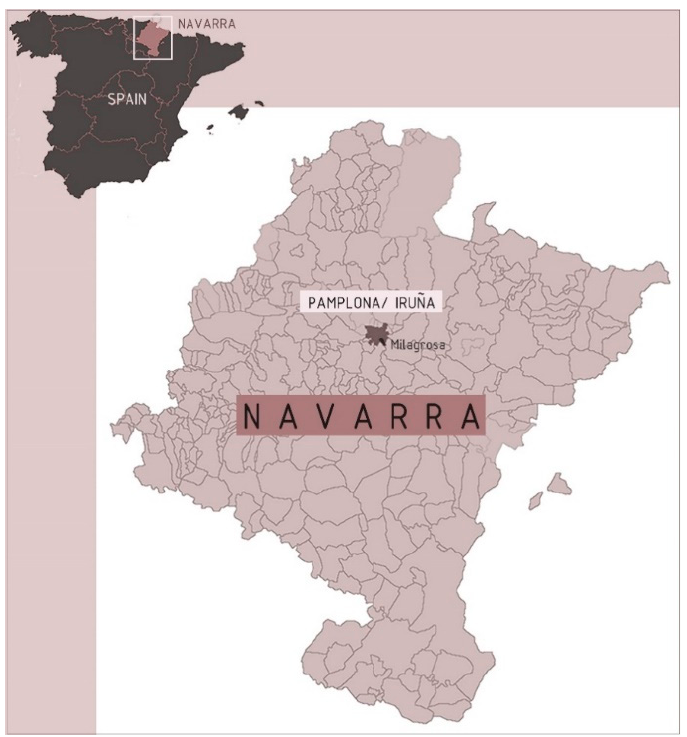
Figure 1. Location